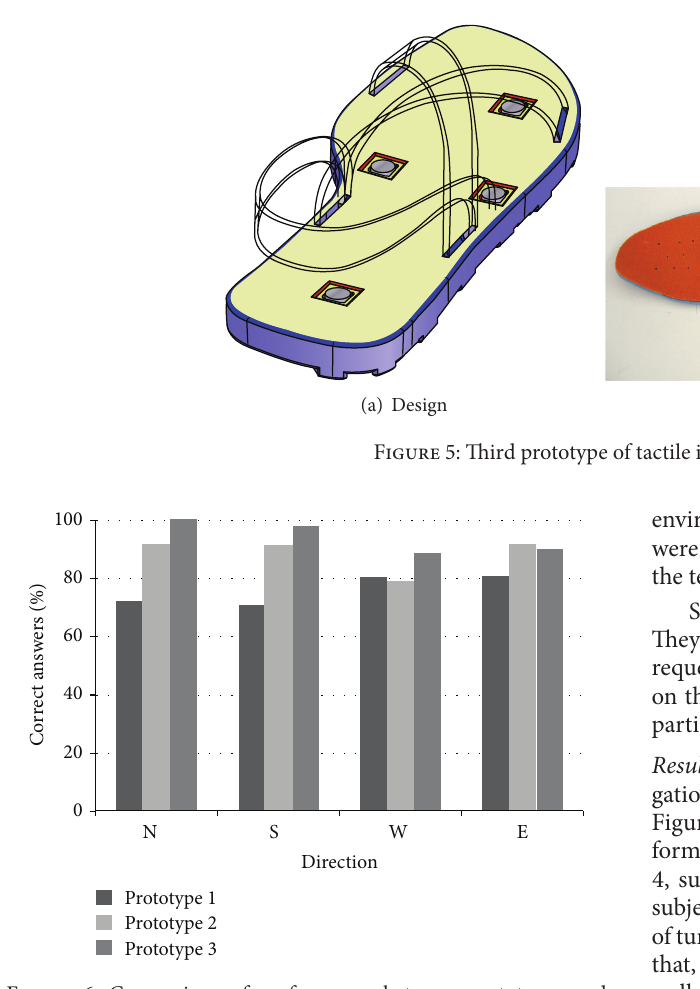
Figure 6: Comparison of performance between prototypes and tactile